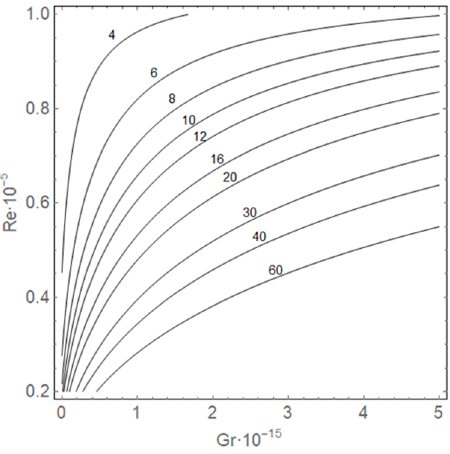
Figure 8. Isolines of the dimensional length E of the methane cloud in the phase plane of dimensionless parameters Re-Gr